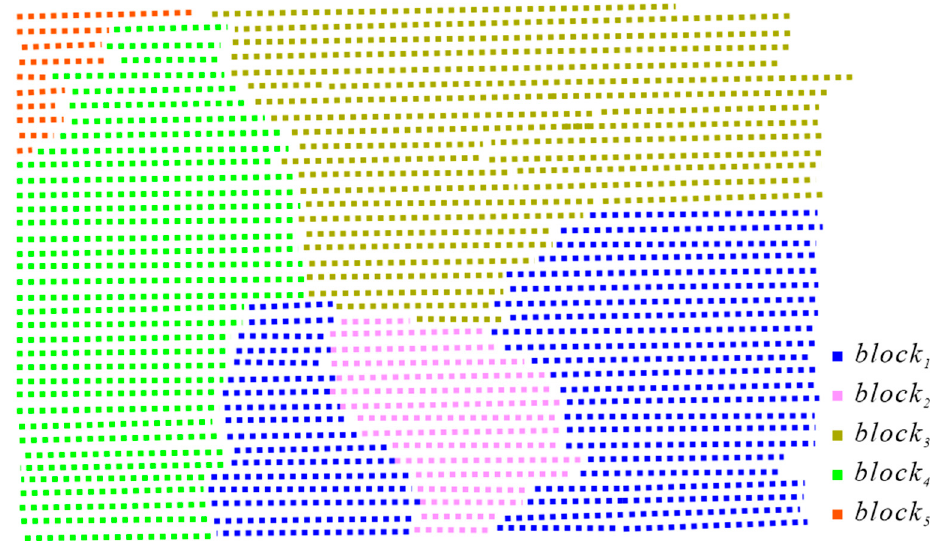
Figure 2. Diagram of the spatial discontinuity of image